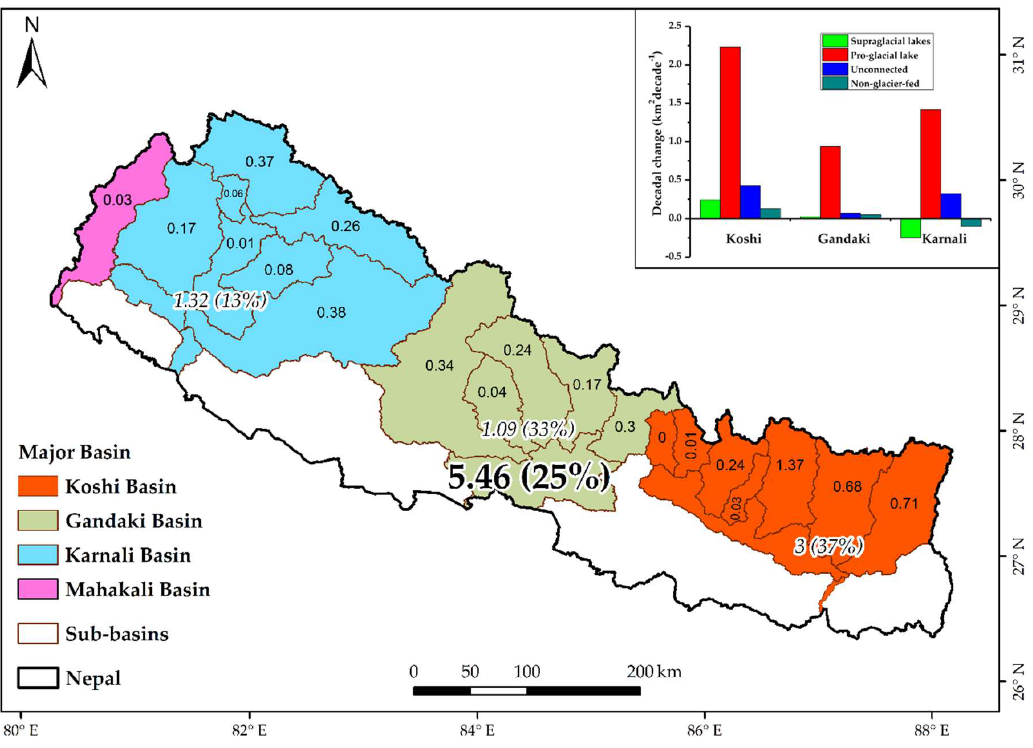
Figure 7. Decadal expansion (km 2 decade −1 ) of glacial lakes from 1987 to 2017 for different sub-basins of the major river basins in Nepal. The inset plot shows the decadal changes (km 2 decade −1 ) of glacial lakes by type in three major river basins. From 1987 to 2017, the glacial lakes in the Nepal Himalaya expanded by 5.46 km 2 decade −1 and the overall change in the total area of glacial lakes was 25%. The values in the sub-basin indicate the changes in glacial lakes (km 2 decade −1 ) from 1987 to 2017. Refer to Figure 1 for the names of the respective sub-basins.